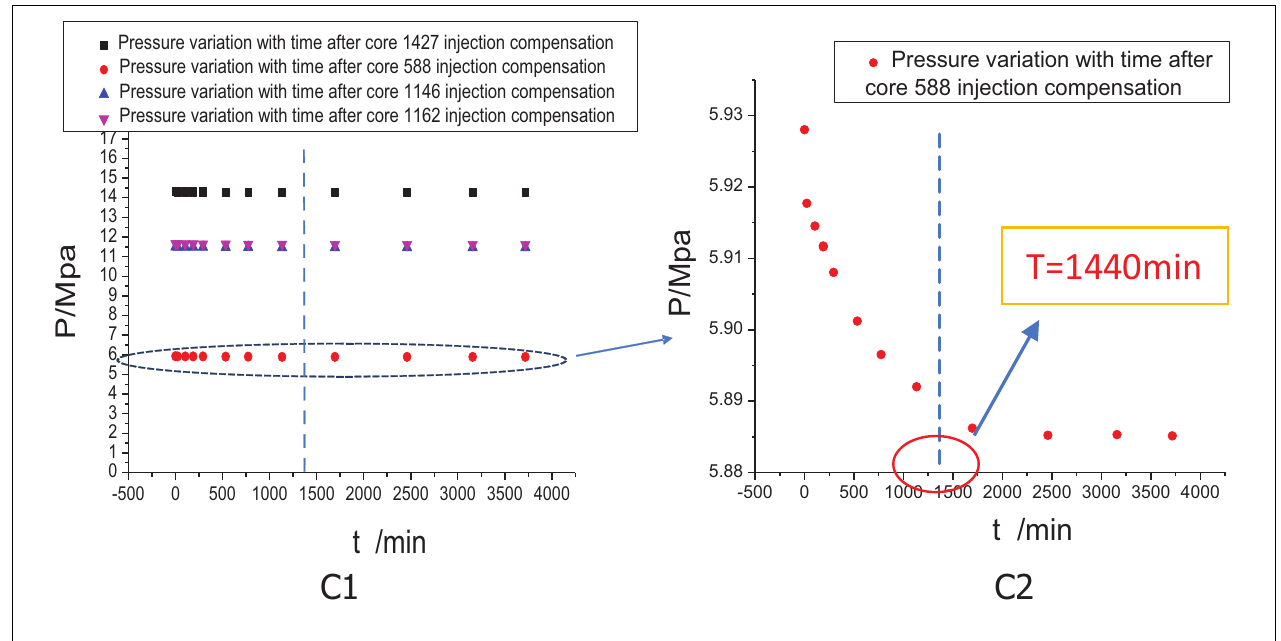
FIGURE 7 | The equilibrium time determination.